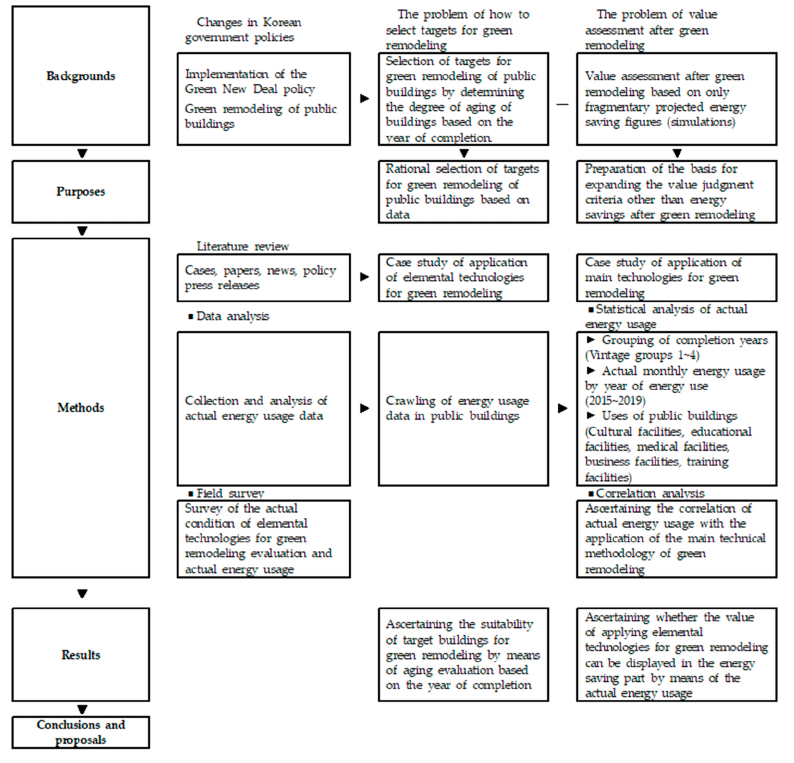
Figure 1. Research flowchart.